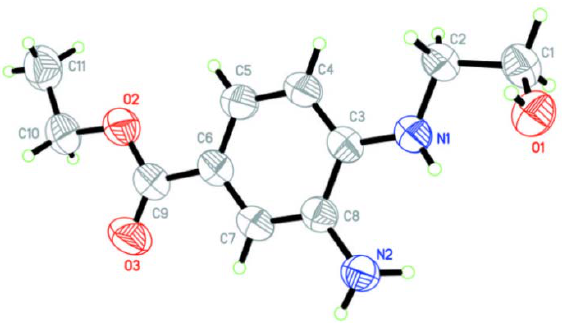
Figure 1. ORTEP digram of 3 (CCDC